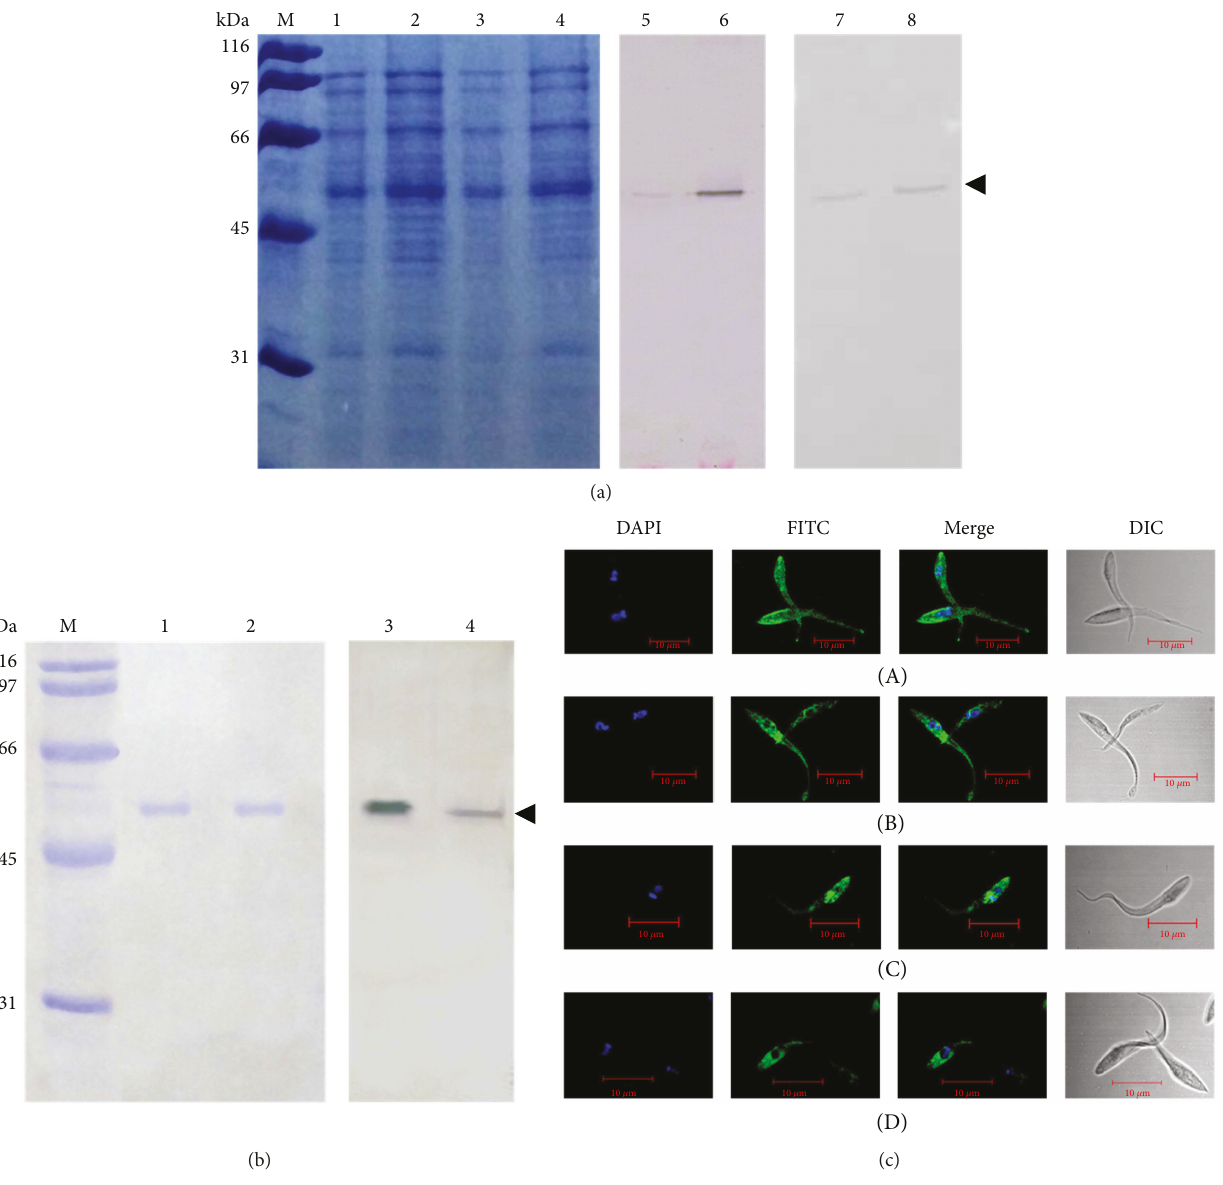
Figure 1: T. cruzi enolase immunodetection. (a) Total extract of T. cruzi soluble proteins and its respective replica for western blotting. Lane M: molecular weight marker; lanes 1 and 3: total soluble proteins (10 μ g); lanes 2 and 4: total soluble proteins (20 μ g); lanes 5 and 6: western blot of immobilized proteins with polyclonal antibodies anti-rTcENO; lanes 7 and 8: western blot of immobilized proteins with polyclonal antibodies anti-pBKTcENO. (b) Puri fi ed rTcENO and its respective replica for western blotting. Lane M: molecular weight marker; lanes 1 and 2: rTcENO (10 μ g); lane 3: western blot with pool of polyclonal antibodies anti-rTcENO; lane 4: western blot with pool of polyclonal antibodies anti-pBKTcENO. The arrowhead indicates the signal for a band of approximately 46 kDa (the TcENO estimated weight). (c) Indirect immuno fl uorescence assay. The secondary antibody that recognized the anti-rTcEno was FITC labeled (green fl uorescence). Nuclear and kinetoplast DNA were stained with DAPI and shown by blue fl uorescence. Each image is a representative of at least two independent experiments and captured by confocal microscope. (A) Nonpermeabilized parasite with anti- T. cruzi polyclonal antibodies; (B) nonpermeabilized parasite with anti-rTcENO polyclonal antibodies; (C) permeabilized parasite with anti- T. cruzi polyclonal antibodies; (D) permeabilized parasite with anti-rTcENO polyclonal